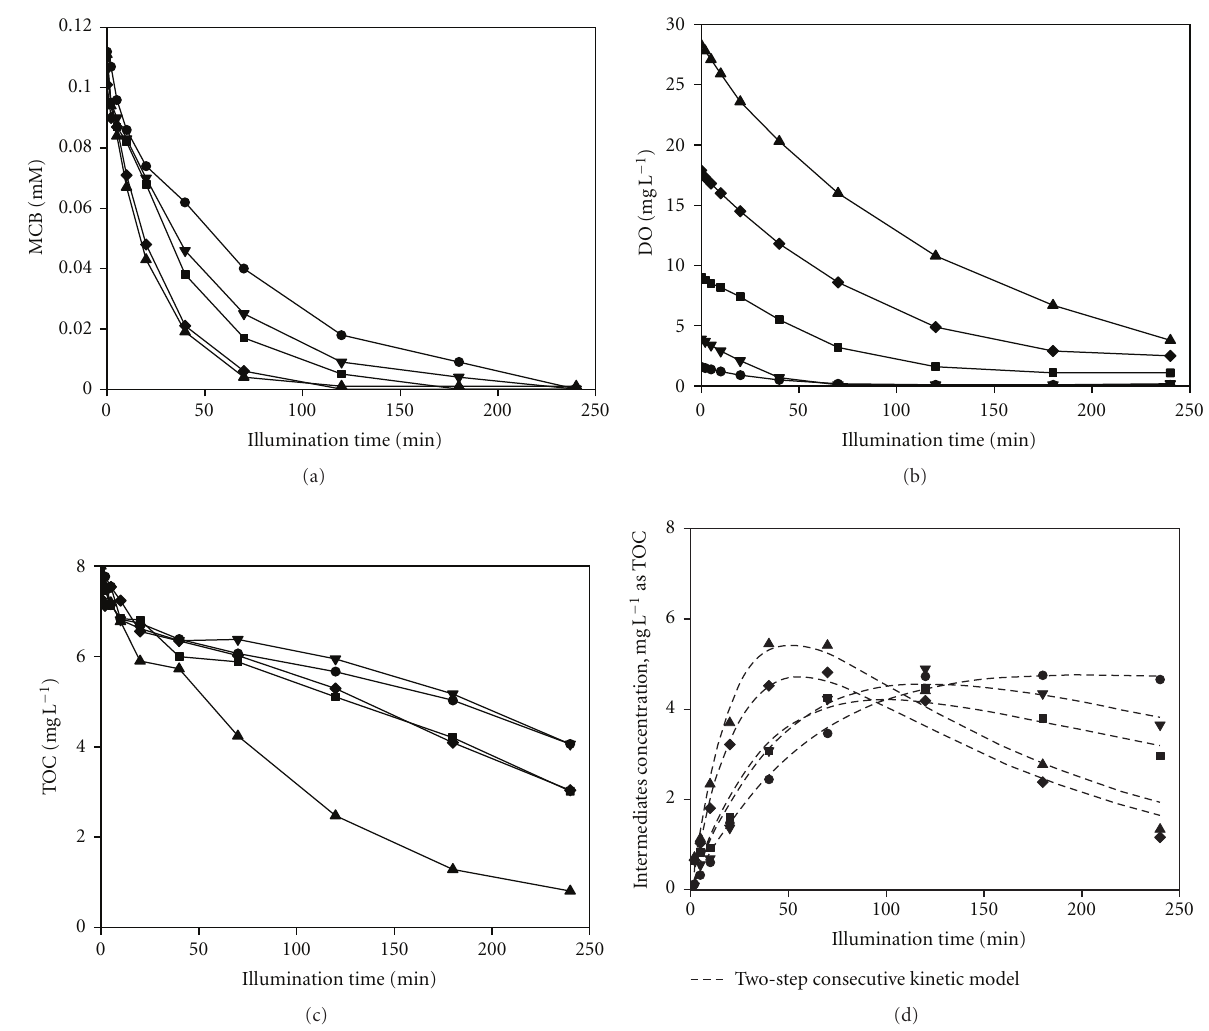
Figure 2: Concentration profiles of (a) MCB, (b) DO, (c) TOC, and (d) intermediates during photocatalytic degradation of MCB at various initial DO concentrations: ( (cid:2) ) 1.6 mgL − 1 , ( (cid:2) ) 3.9 mgL − 1 , ( (cid:3) ) 9.0 mg L − 1 , ( (cid:4) ) 17.9 mg L − 1 , and ( (cid:5) ) 28.3 mgL − 1